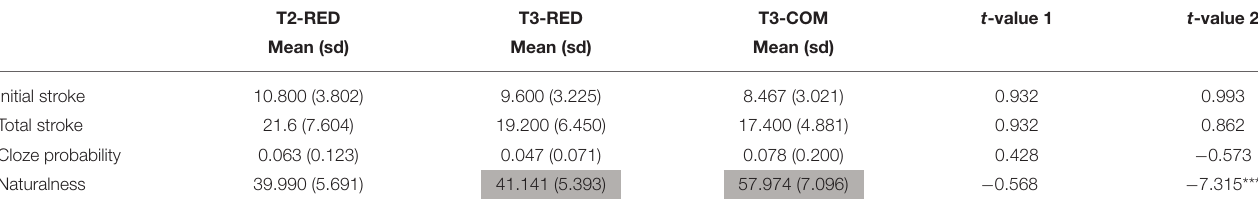
TABLE 3 | Two-sample t -tests (T2-RED vs. T3-RED; T3-RED vs. T3-COM).